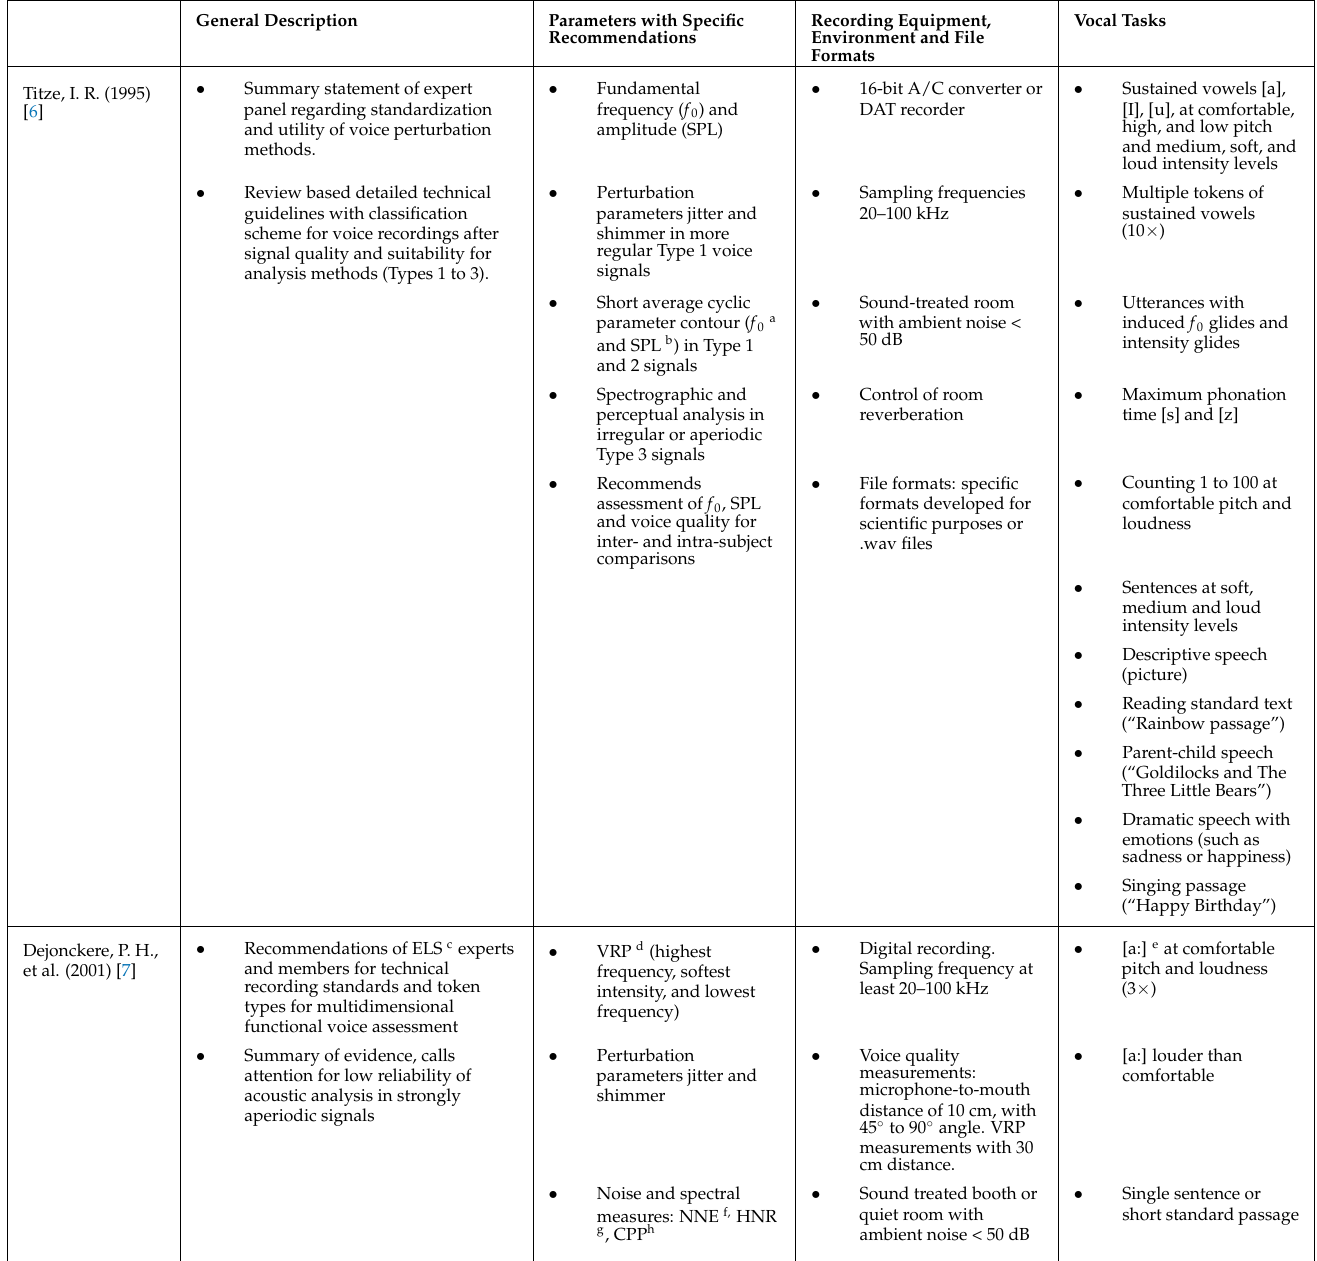
Table 1. Summary of Acoustic Analysis Recommendations and